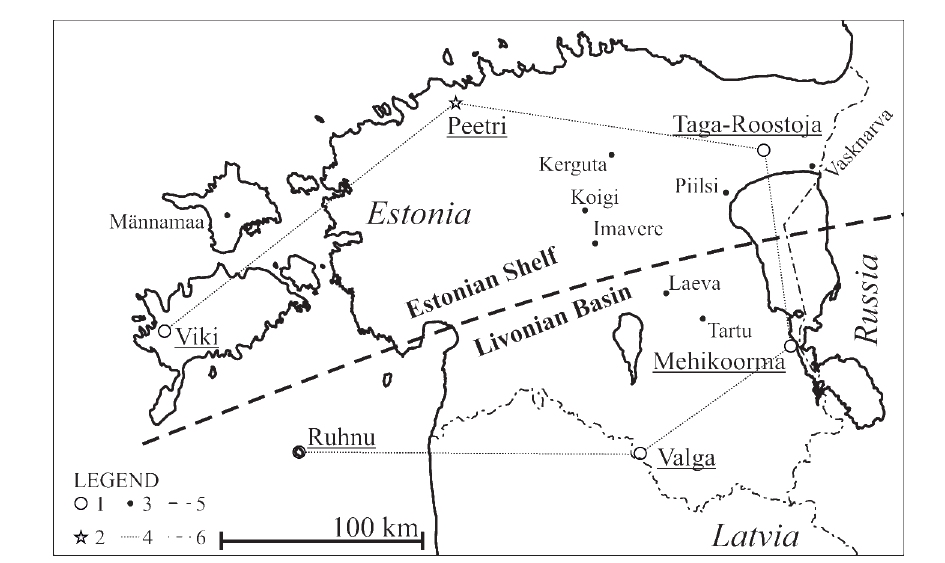
Fig. 1. Location of the sections discussed or referred to in the text. Legend: 1, core section shown in Fig. 6; 2, outcrop; 3, supple­ mentary core sections referred to in the text; 4, profile in Fig. 6; 5, facies boundary; 6, state